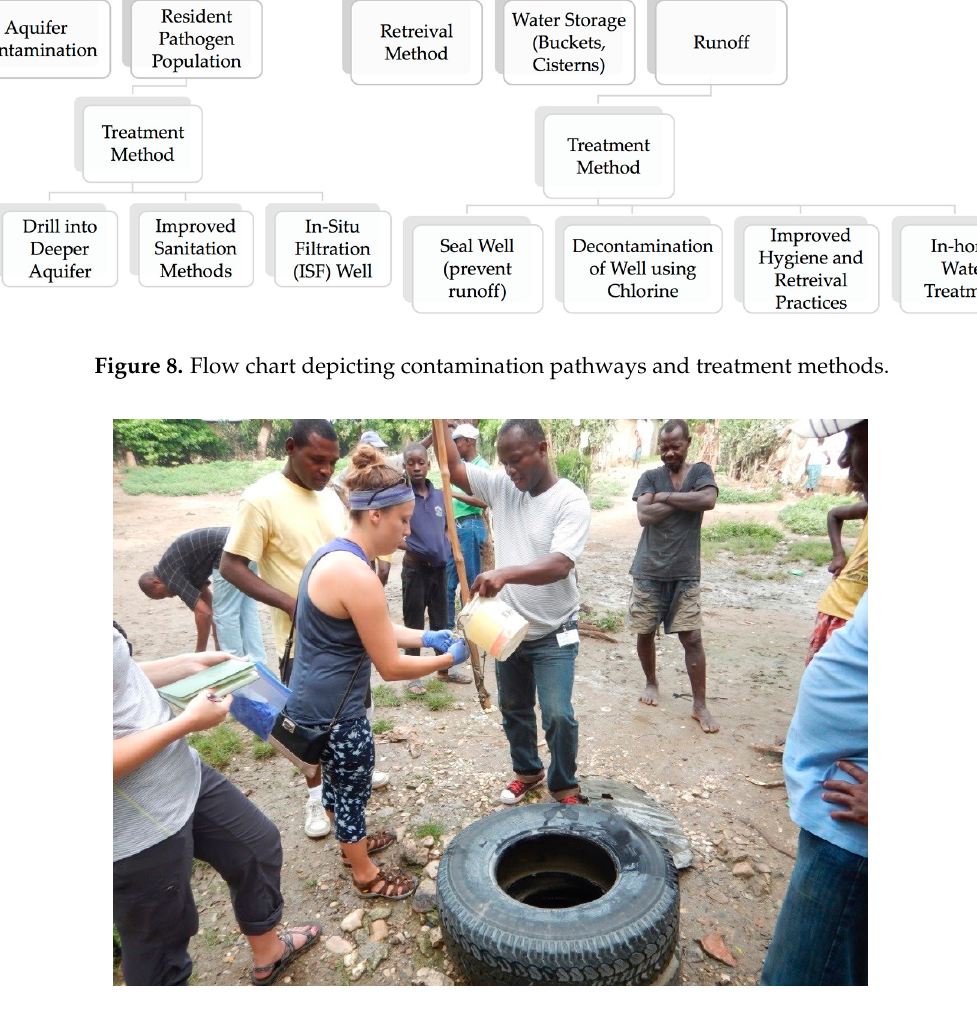
Figure 9. Bucket retrieval methodology.